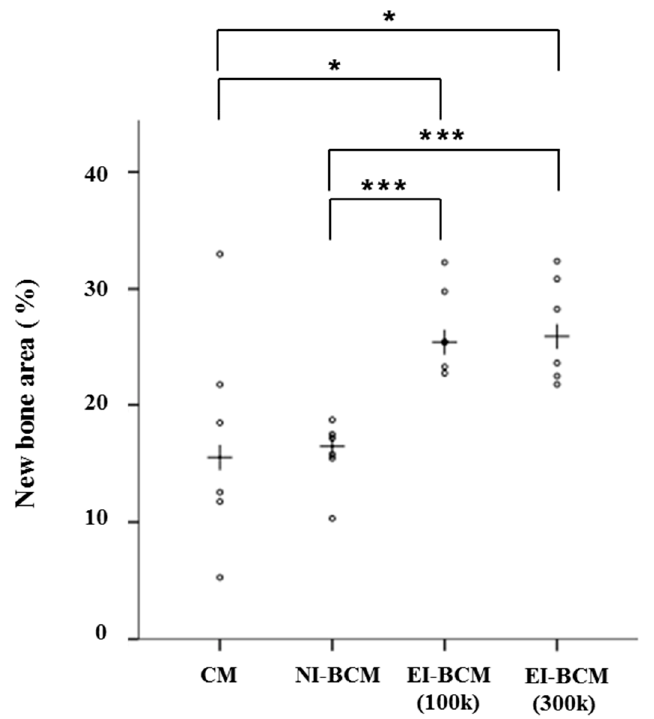
Figure 12. Scatter plots and median (crosses) new bone area percentages (%) at 4 weeks after surgery (* p < 0.05, *** p < 0.001).